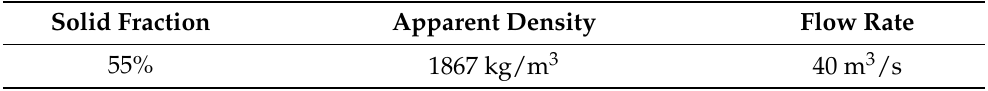
Table 1. Characteristics of the obtained debris